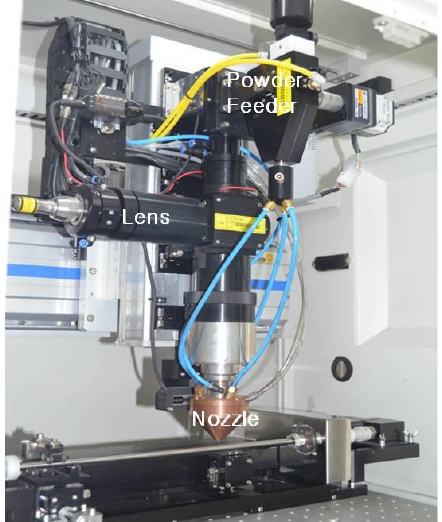
Figure 1. Appearance of the laser equipment for coating.